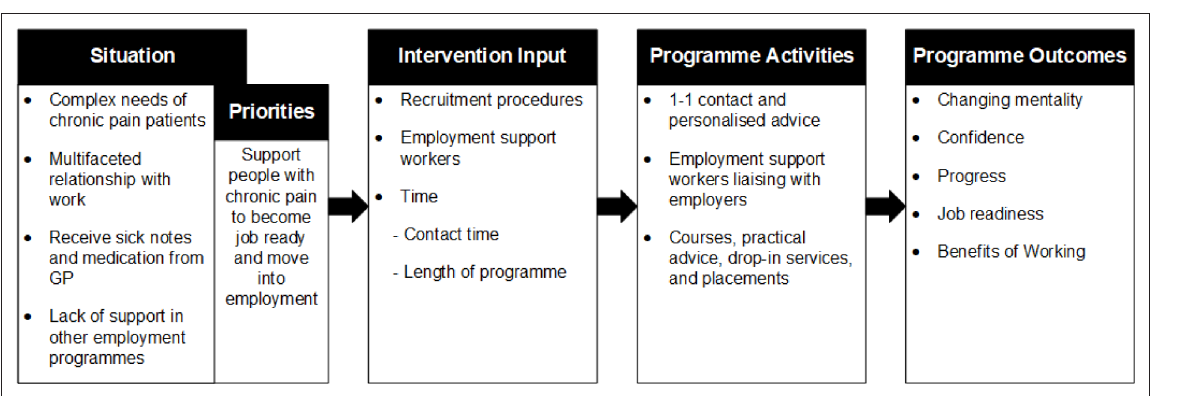
Figure 1 Logic model of Individualised Placement and